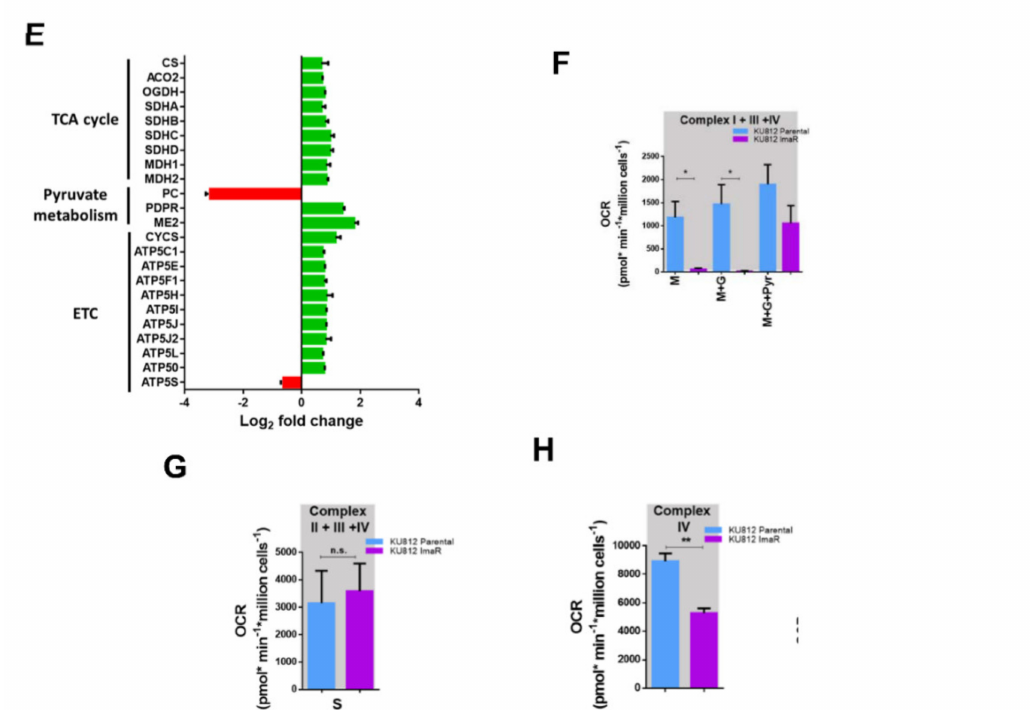
Figure 6. Characterization of mitochondrial respiration in KU812 imatinib-resistant vs. KU812 Parental cells. ( A – C ) Oxygen consumption rate (OCR) values were measured under normoxia during sequential injection of oligomycin, CCCP, and Rot + Ama in KU812 Parental and imatinib-resistant (ImaR) cells previously incubated under normoxic and hypoxic conditions. Basal and maximal respiration of cells incubated under normoxic (panel A ) and hypoxic (panel B ) conditions were calculated. ATP production-associated respiration of KU812 Parental vs. ImaR cells previously incubated under normoxic and hypoxic conditions (panel C ) were calculated as explained in material and methods. ( D ) Fatty acid, glutamine and glucose / pyruvate contributions to mitochondrial respiration in KU812 Parental and ImaR cells previously incubated under normoxic and hypoxic conditions were determined by measuring OCR under normoxia during sequential injections of Etomoxir, BPTES, UK5099 and Oligomycin inhibitors. Data were normalized by protein. Data are provided as mean ± SD of n = 3. ( E ) Protein expression profiling of proteins associated with mitochondrial metabolism, pyruvate metabolism and electron transport chain. Log2 fold change values were calculated and represented by green color = protein up-regulation; and red = protein down-regulation. (mean ± SD for n = 2 replicates. ( F – H ) Oxygen consumption rate (OCR; expressed as picomoles (pmol) per minute (min) per million of cells (Mill)) measurements of permeabilized KU812 Parental and ImaR cells was determined at 37 ◦ C in 2 mL glass chambers using a two-channel, high-resolution Oxygraph respirometer in normoxia as indicated in material and methods. OCR was measured after sequential injections of substrates and inhibitors with an addition of 5 mM ADP together with the first substrate added. Data (mean ± SD for n = 3 of n = 3 independent experiments) was analyzed using DatLab7 software. OCRs). The oxygen flow in these states was corrected by the subtraction of non-mitochondrial respiration (ROX), which was obtained after the addition of antimycin (Ama). For ( F ) (approach to study of complex I): 2 mM malate (M), 10 mM glutamate (G), and 5 mM pyruvate (P). For ( G ) (approach to study complex II): 10 mM succinate (S). For ( H ) (approach to study complex IV activity): 5 mM Ascorbate (As) plus 0.5 mM N,N,N (cid:48) ,N (cid:48) -tetramethyl-p-phenylendiamine dihydrochloride (TMPD). Statistically significant di ff erences in all the panels were determined by two-tailed independent sample Student’s t -tests: * p < 0.05, ** p < 0.01, *** p < 0.001, and p ≥ 0.05 (n.s. = non-significant di ff erences). Abbreviations: ACO, aconitase; ATP5, ATP synthase; CS, citrate synthase; CYCS, cytochrome c; OGDH, oxoglutarate dehydrogenase; PC, pyruvate carboxylase; PDPR, pyruvate dehydrogenase phosphatase regulatory subunit; MDH, malate dehydrogenase; ME, malic enzyme; and SDH, succinate